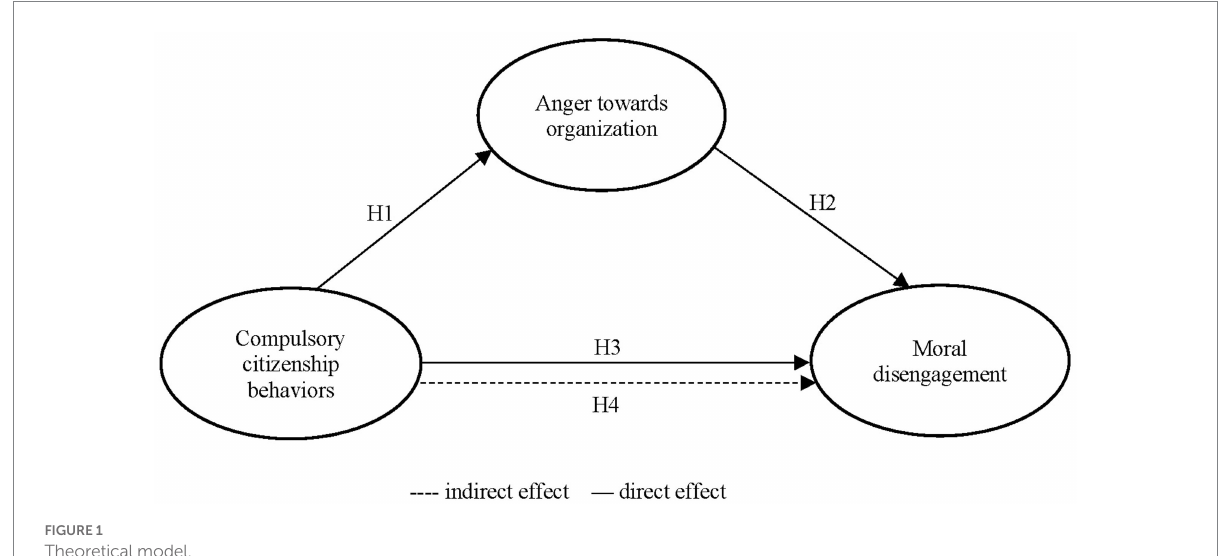
FIGURE 1 Theoretical model.